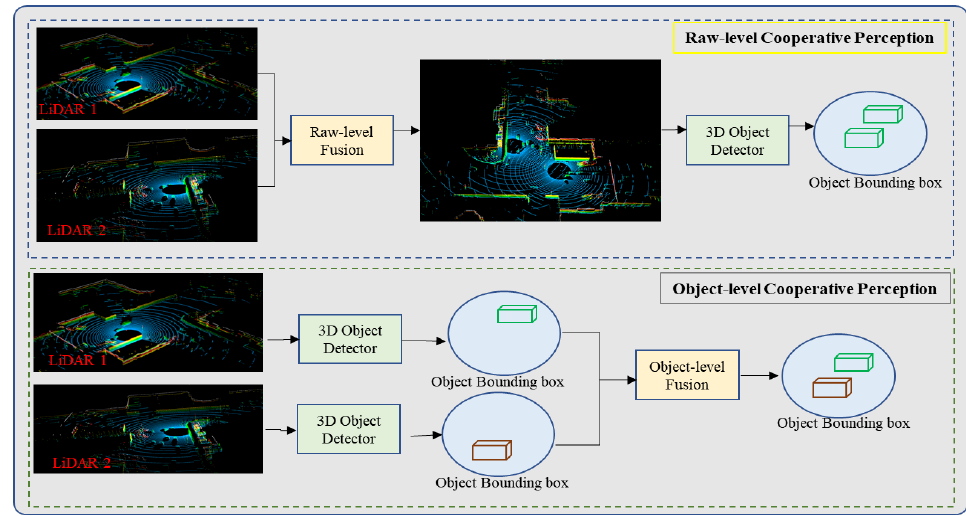
Figure 6. Logical illustration of raw-level and object-level schemes for cooperative object